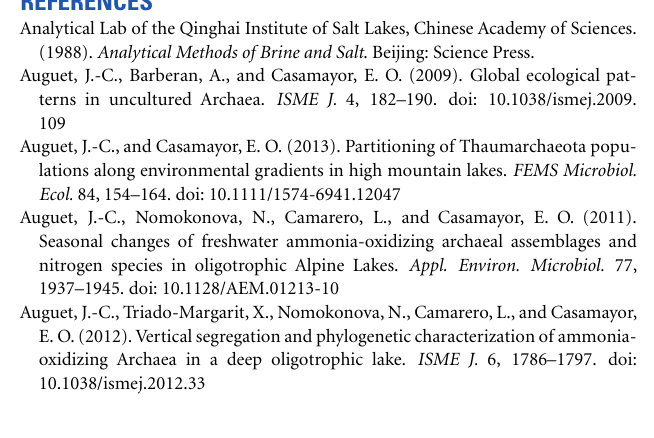
FIGURE 7 | Jaccard similarity-based cluster analysis of the amoA gene communities in different habitats worldwide. Panels (A) and (B) are for water and sediment/soil samples, respectively. (A) The archaeal amoA gene sequences obtained in this study were compared with those previously reported in the waters of Monterey Bay, the EasternTropical North Pacific, and the Black Sea (Francis etal., 2005), and Arctic Ocean and Antarctic coasts